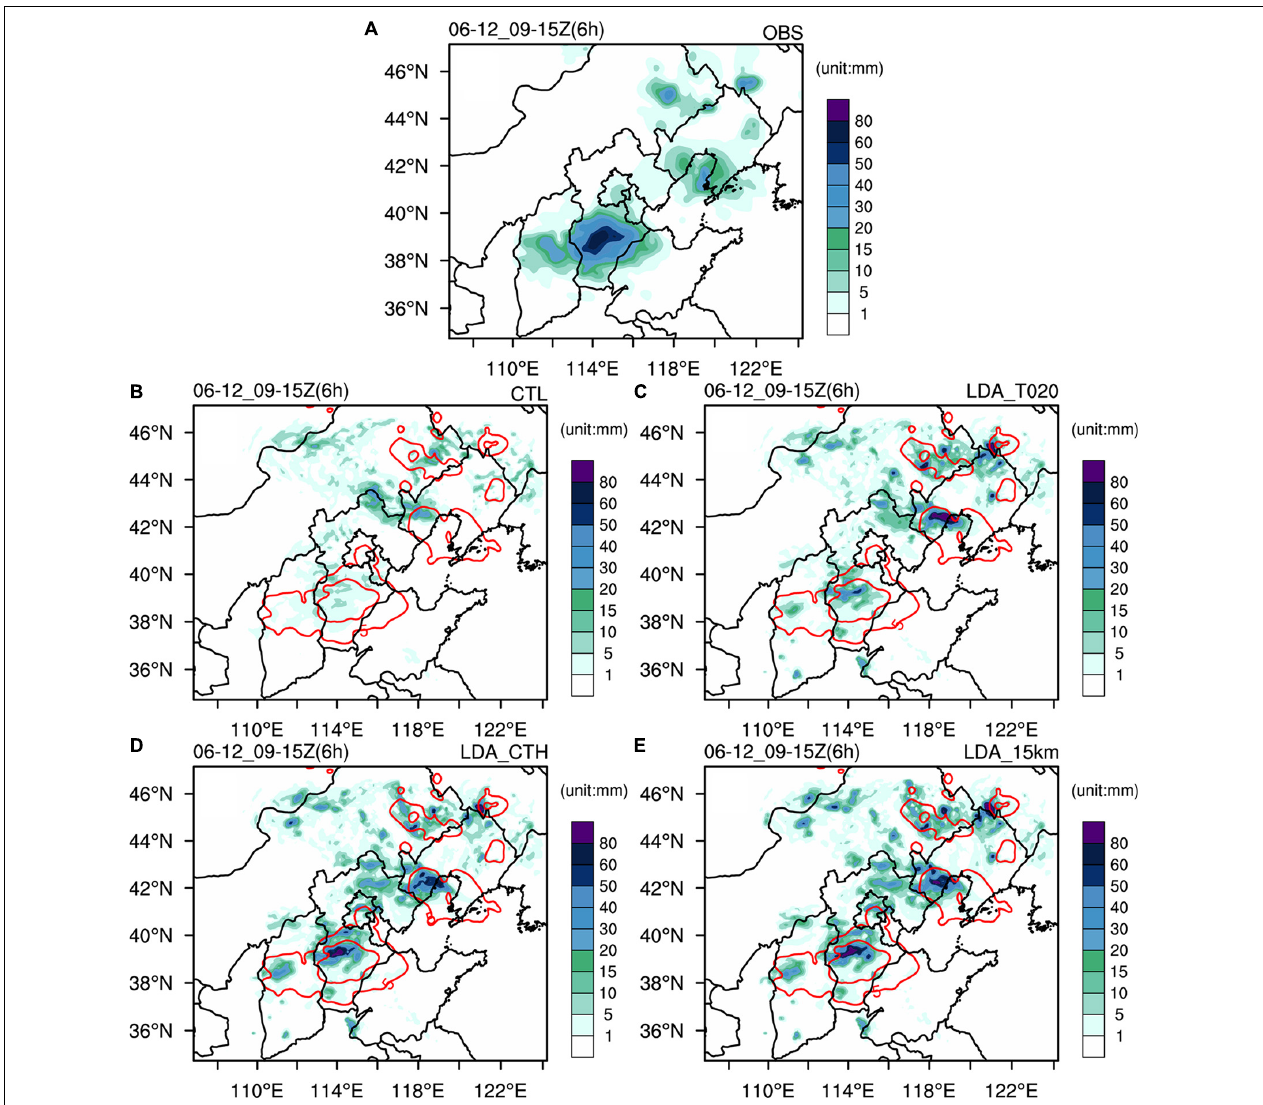
FIGURE 13 | As in Figure 11 , but for case 2 from 0900 UTC to 1500 UTC on 12 June 2018 for each experiment. (A) Observations (OBS), (B) CTL, (C) LDA_T020, (D) LDA_CTH, and (E)